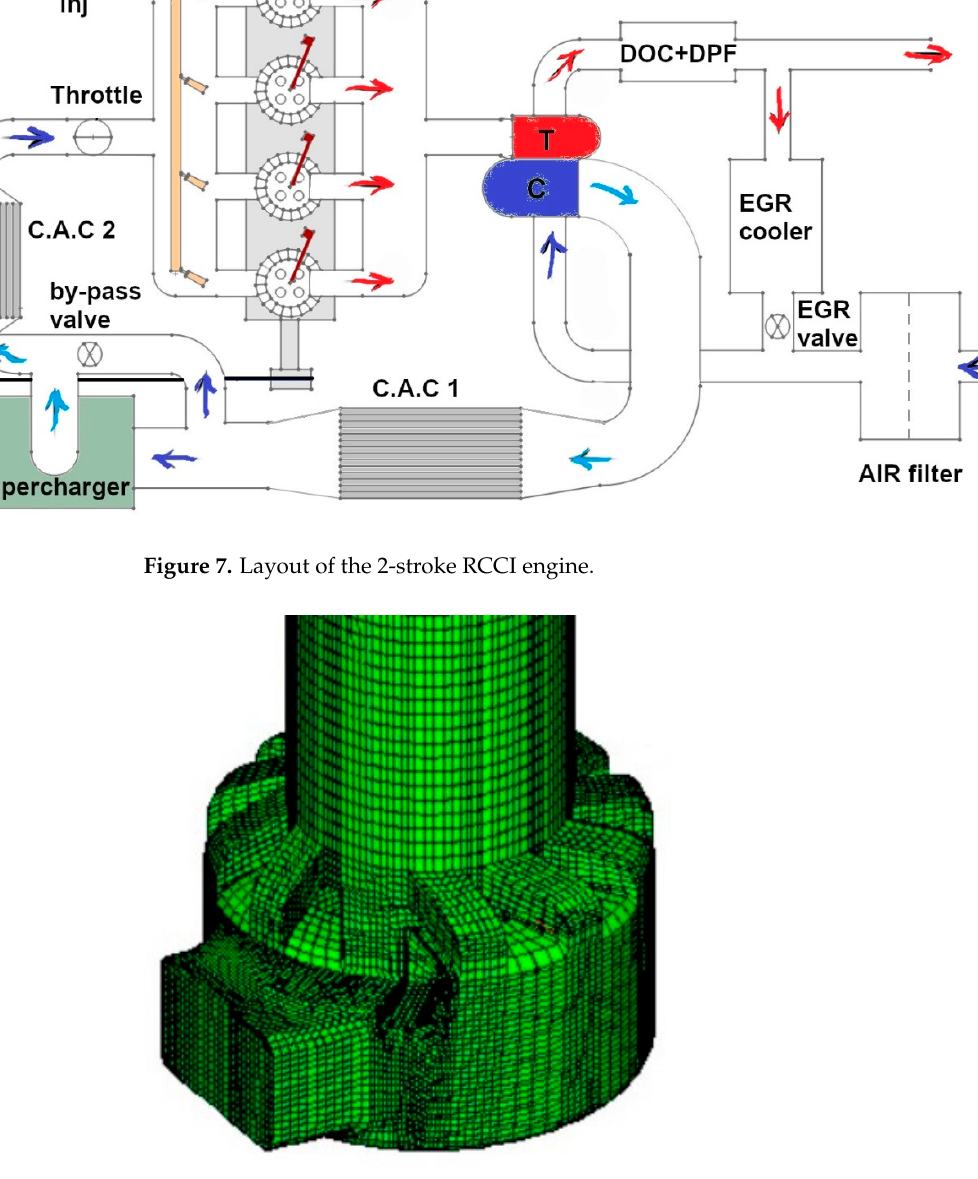
Figure 8. Inlet manifold and ports.